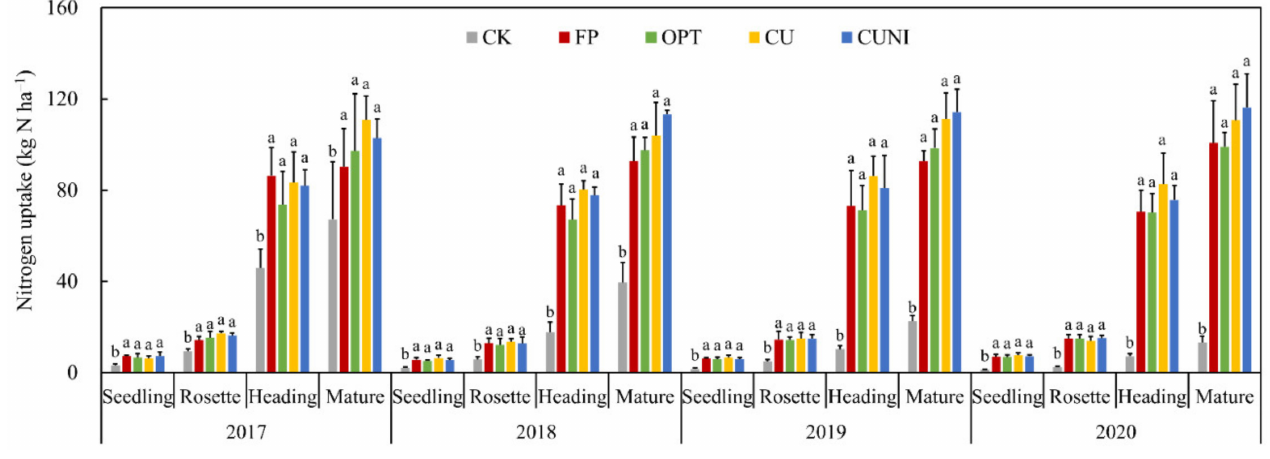
Figure 1. Nitrogen (N) uptake during lettuce growing seasons in 2017–2020. CK, no N fertilizer; FP, conventional urea based on local farmers’ practices; OPT, conventional urea at reduced N rate; CU, polyurethane-coated urea at reduced N rate; CUNI, polyurethane-coated urea at reduced N rate in combination with nitrification inhibitor (NI). Same letter indicates no significant differences at the level of 0.05. Bars represent standard deviations ( n =